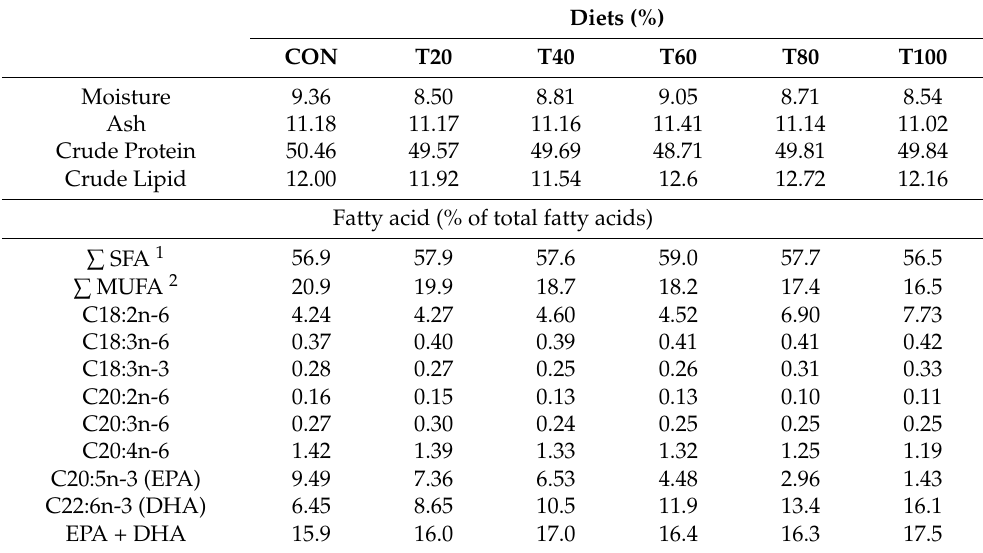
Table 3. Proximate composition (% of DM basis) and fatty acids composition (% of total fatty acid) of experimental